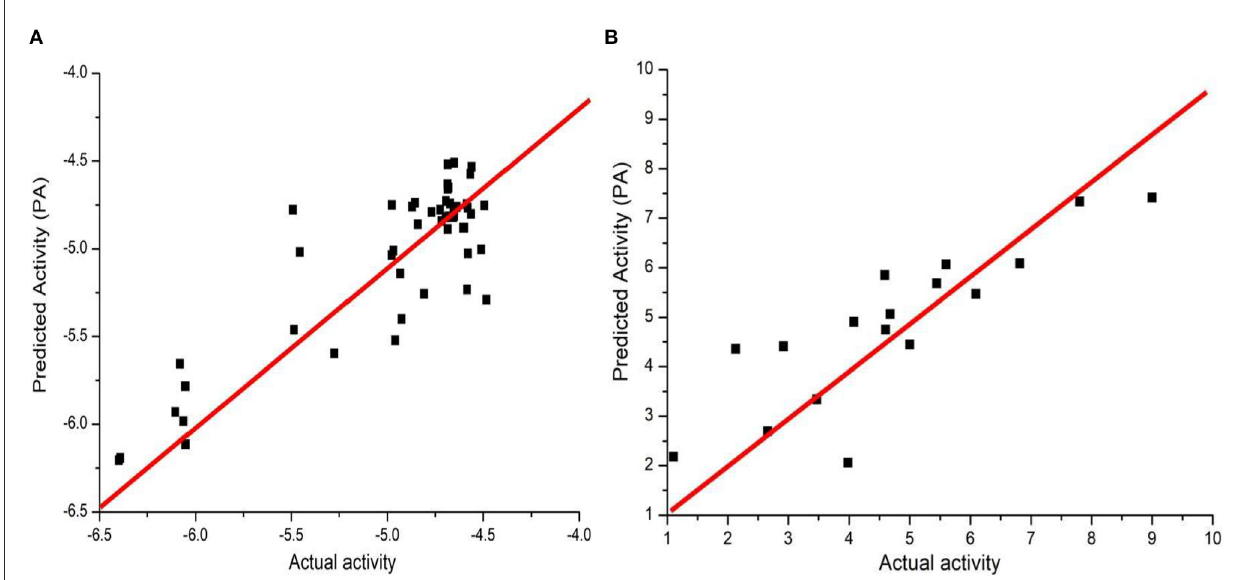
FIGURE4 Predicted vs. actual activities obtained for test sets. (A) Prediction of Caco-2 permeability using JavaDL with five descriptors: BCUT_ PEOE_3, GCUT_SLOGP_1, mr, a_base, vsa_base. (B) Prediction of hERG activity with five descriptors: GCUT_PEOE_3, reactive, SlogP_V SA1, SlogP_V SA9, and vdw_area.